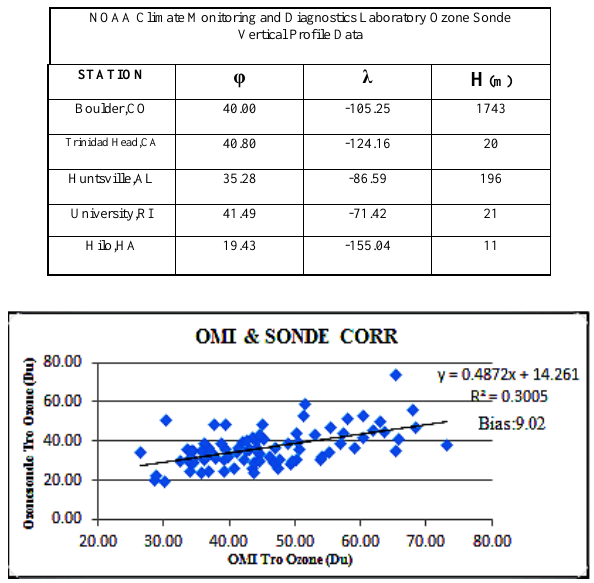
Figure 6- OMI tropospheric ozone and Ozonesonde correlation in urban areas